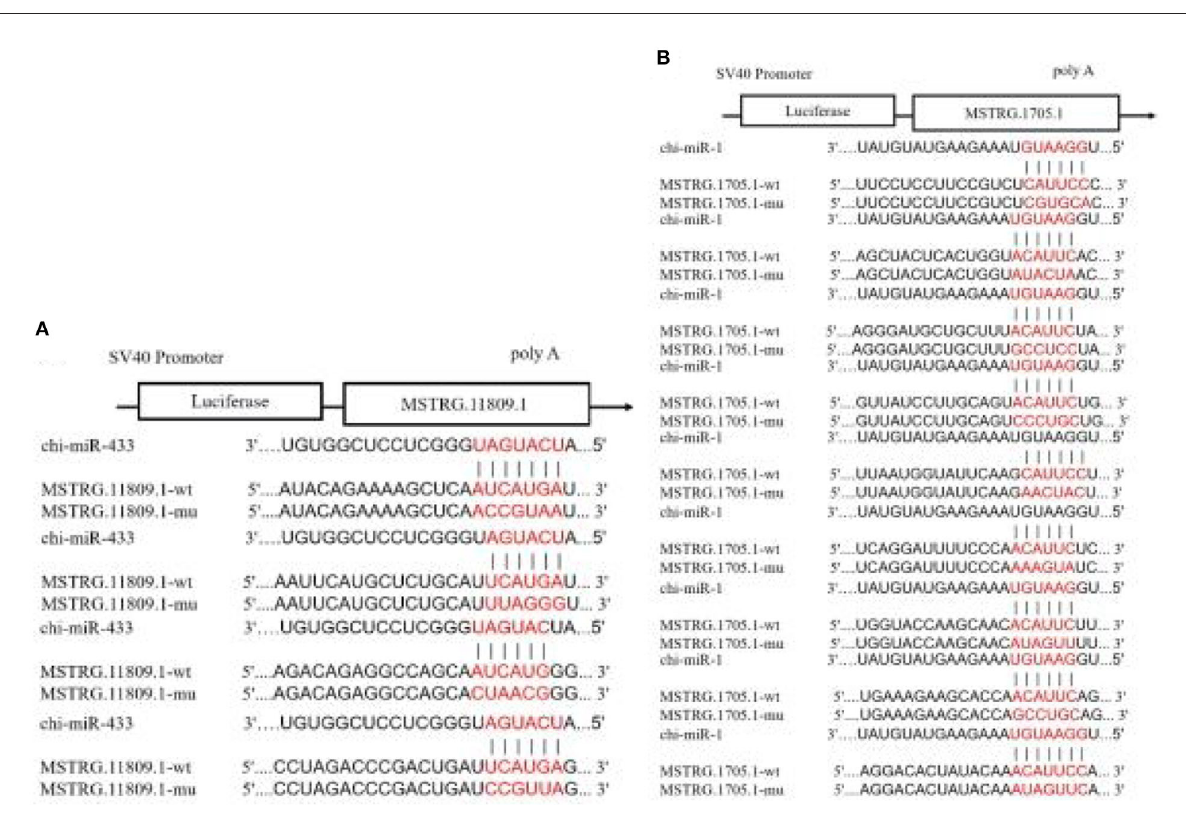
FIGURE10 Prediction of lncRNA-miRNA binding sites and construction of vectors. (A ) The predicted binding site and mutated site of Chi-miR-1 in lncRNA MSTRG.1705.1 . (B) The predicted binding site and mutated site of Chi-miR-433 in lncRNA MSTRG.11809.1 .